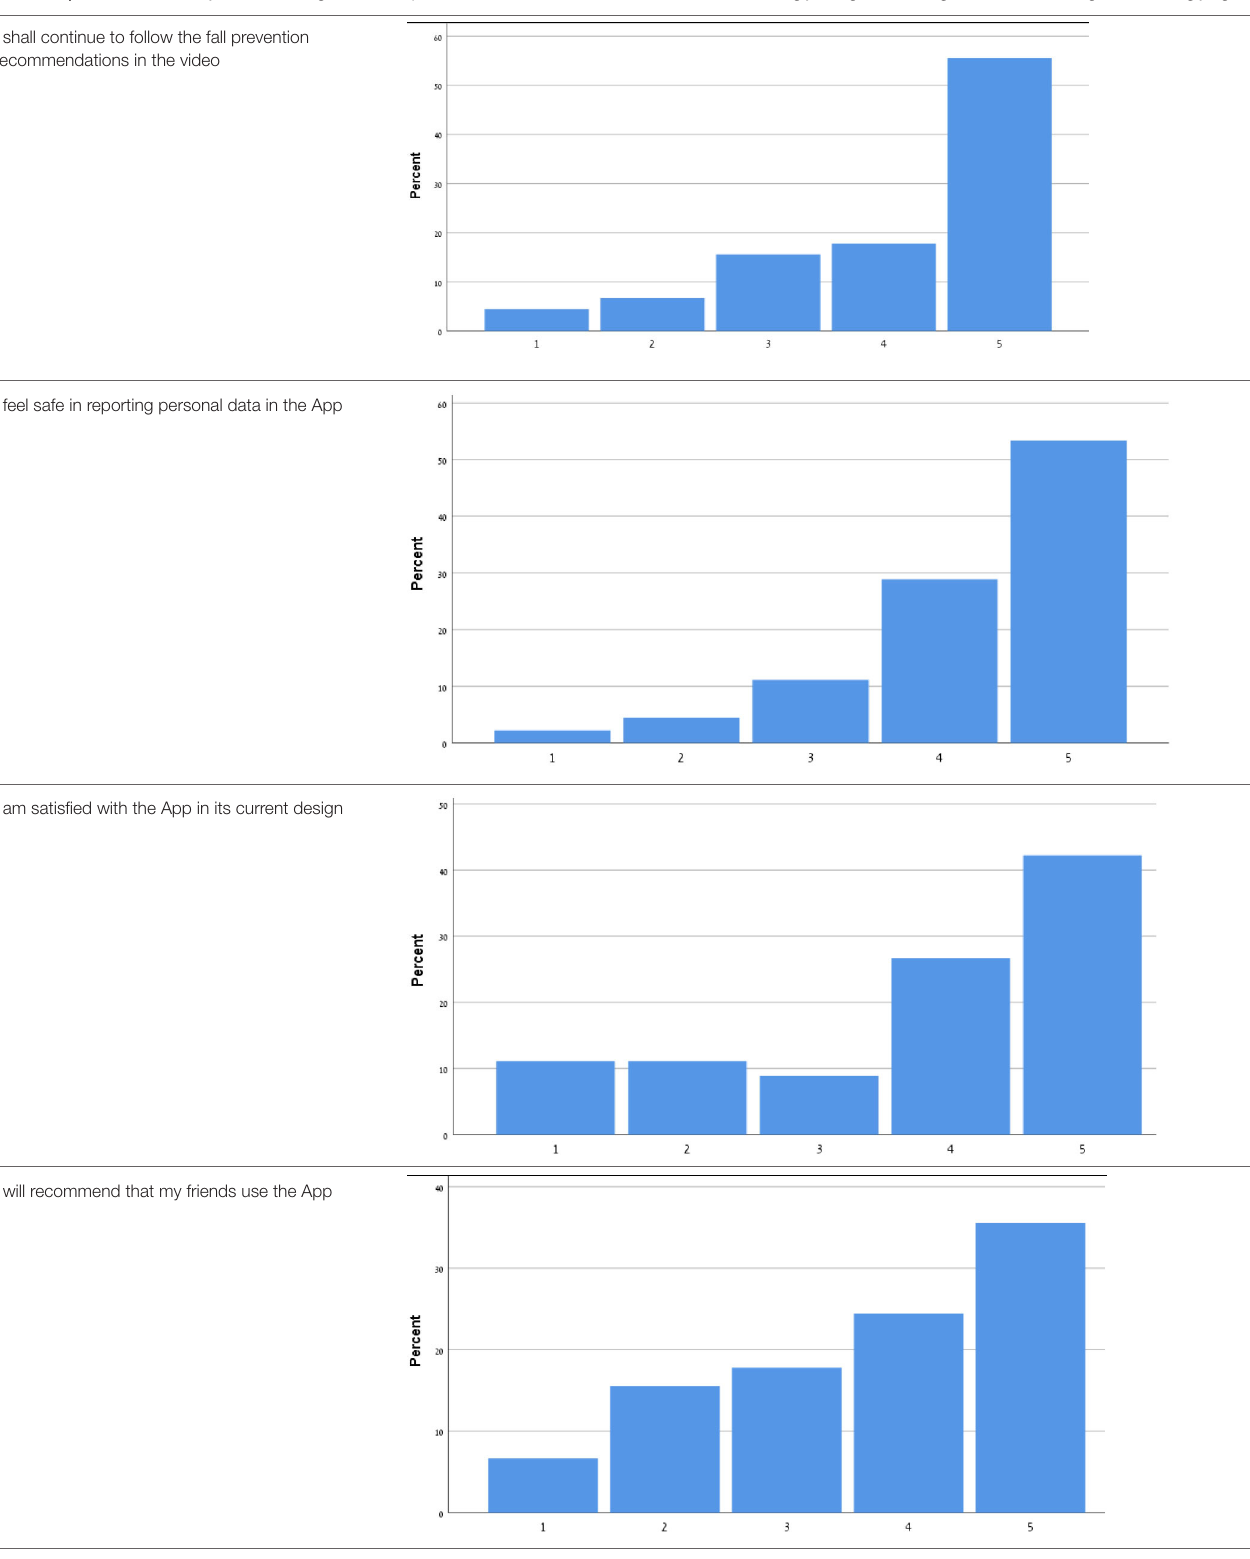
TABLE 9 | Satisfaction survey results among both smartphone and smartTV users scale is between 1-Strongly disagree, 2-Disagree, 3-Neutral, 4-Agree, 5-Strongly